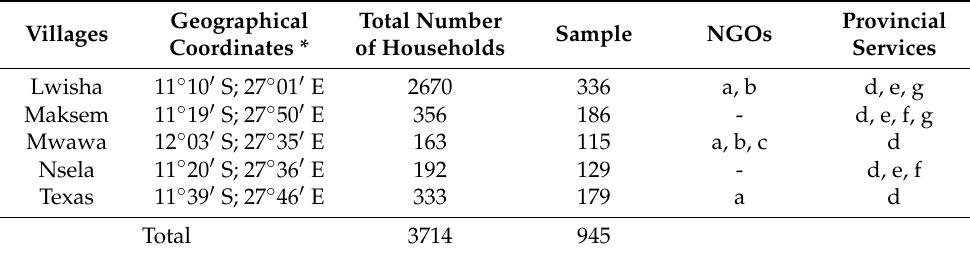
Provincial Services